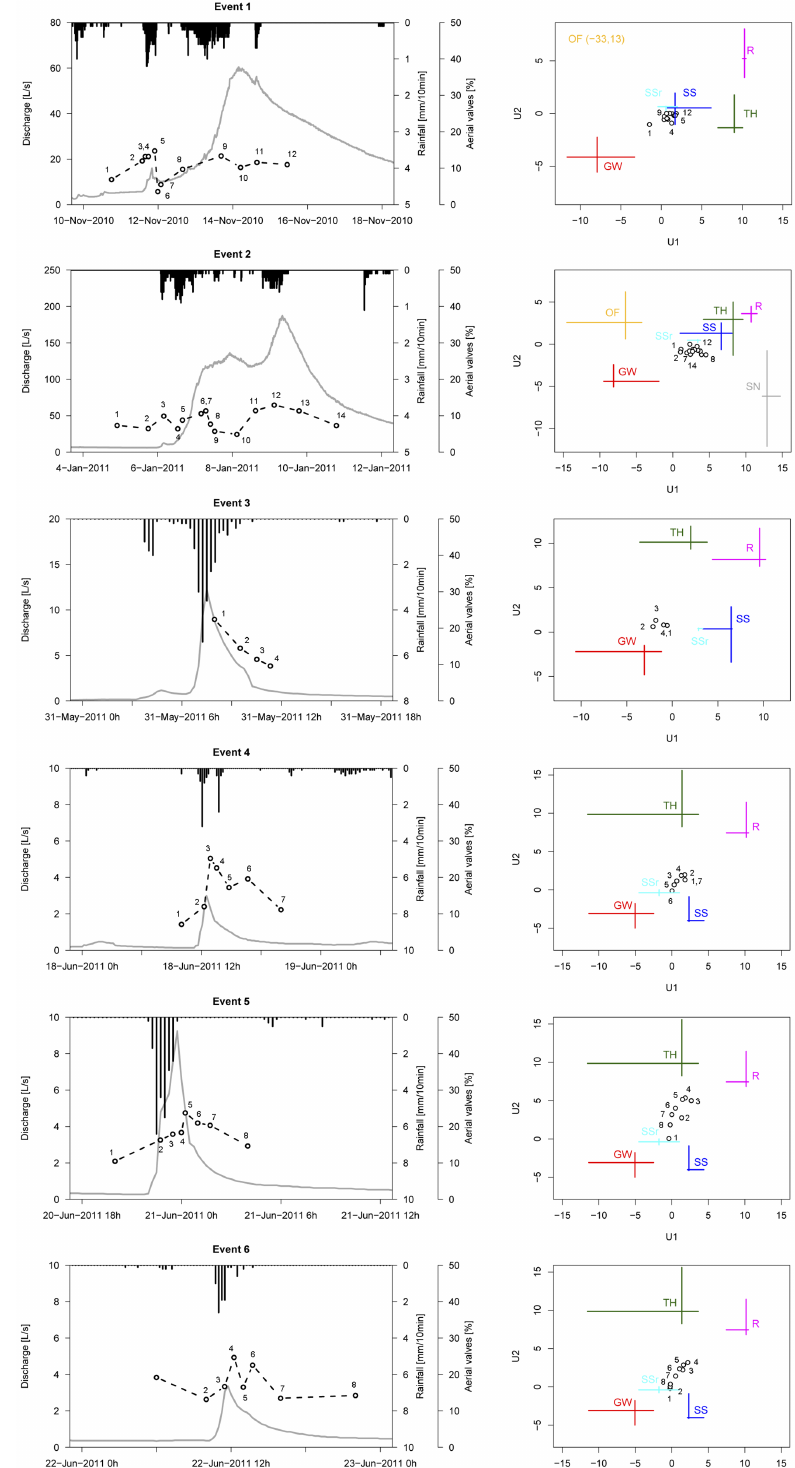
Figure 8. Hydrograph, hyetograph and percentage of aerial valves in the stream water for events 1–6 in the Weierbach catchment (left), and U1–U2 mixing diagrams for each event. End-members are rainfall (R), throughfall (TH), snow (SN), soil water (SS), soil water from the riparian zone (SSr) and groundwater (GW). Bars represent end-member values’ interquartile ranges of samples collected during the month when the event occurred, as well as the previous and following